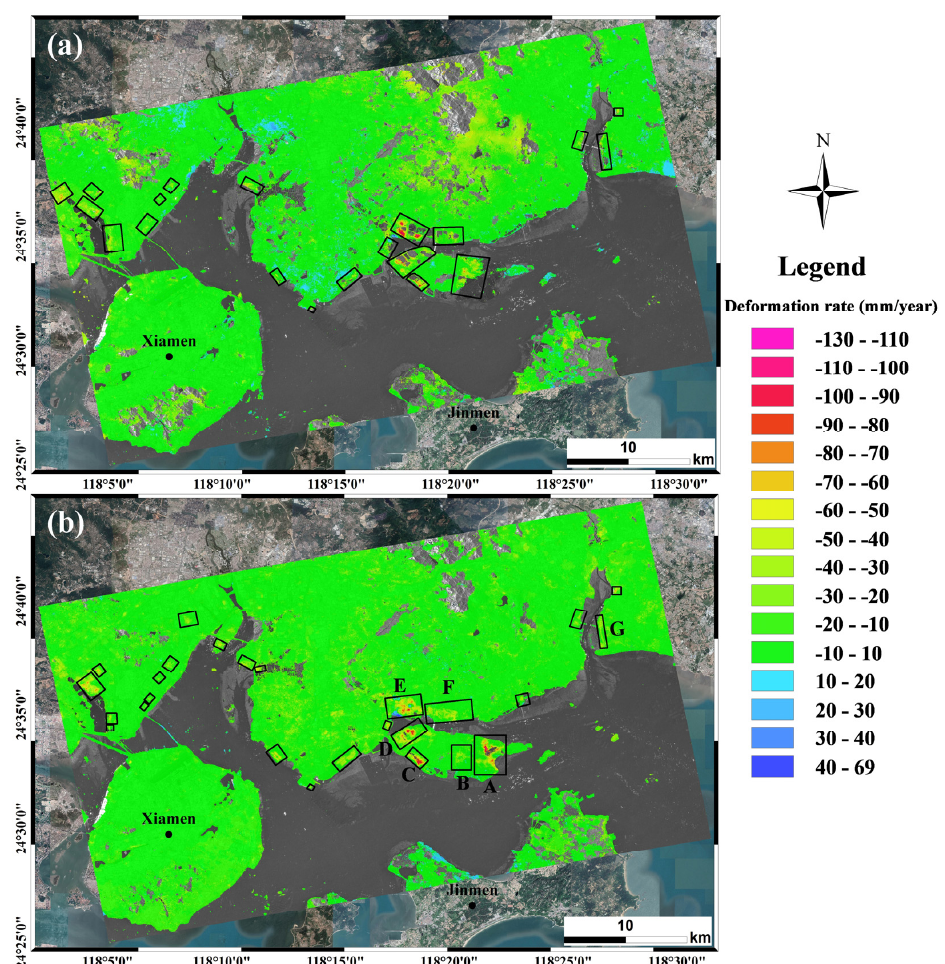
Figure 4. Average deformation rate maps calculated with Sentinel-1 datasets over the whole coastal areas of the city of Xiamen. Black rectangles represent potential deformation areas identified by InSAR, and Regions A–G in Figure 4b are analyzed in Section 5. ( a ) The deformation rate map from